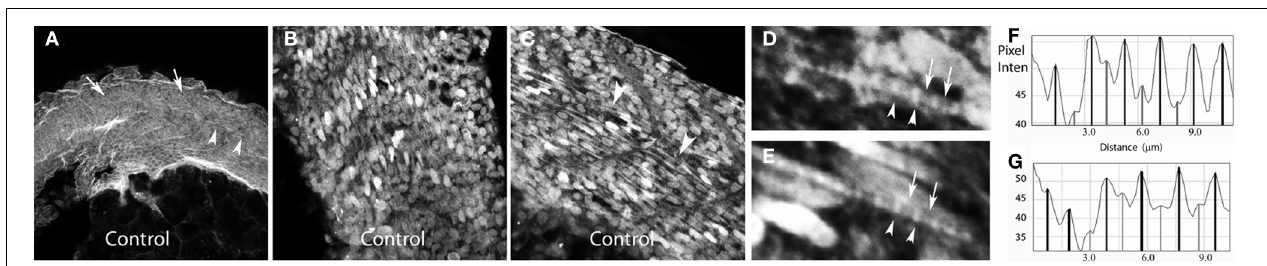
FIGURE 3 | β 1-integrin redistribution occurs very early in myofibrillogenesis to pattern membrane domains overlying new myofibrils. Zebrafishembryosat20 (A) and24 (B–G) hpfwereimmunolabeled for β 1-integrin. Embryos demonstrated clustering of β 1-integrin at new somite boundaries (arrows: A ) with subsequent localization to membrane domains overlying new myofibrils in the more mature somites (arrowheads: A ). (B,C) At the onset of myofibrillogenesis, β 1-integrin localizes diffusely overlying the nascent myofibril before achieving a striated appearance with accumulation